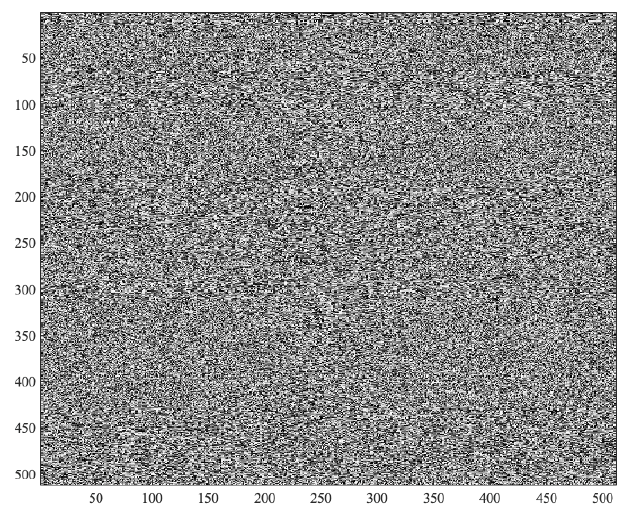
Figure 3. Random numbers generated by the proposed GSR-RNG.